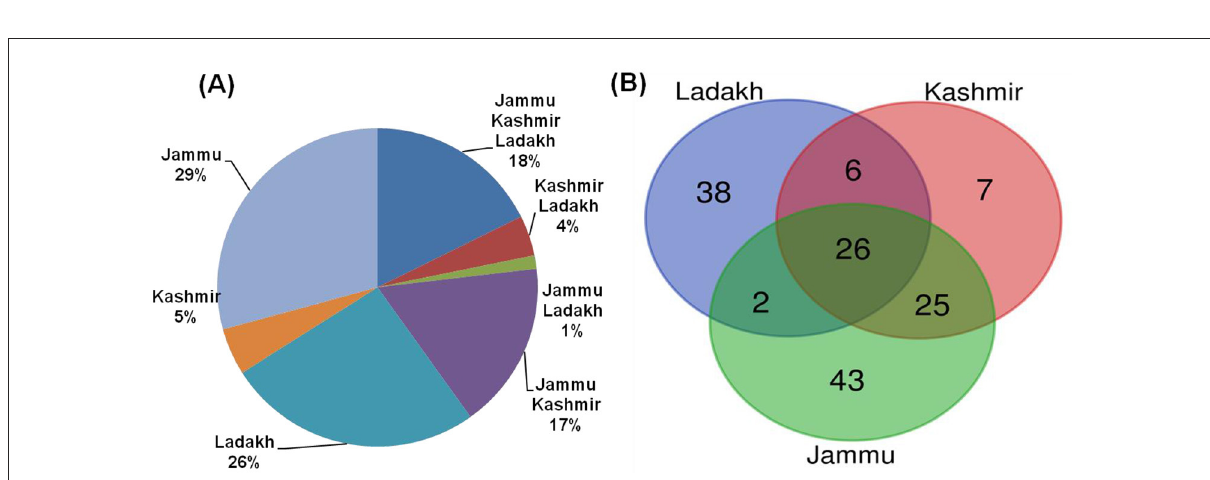
FIGURE8 (A) Showing percentage of similarity (B) Venn diagram showing pattern of ethno-veterinary usage pattern of plant resources in different regions.